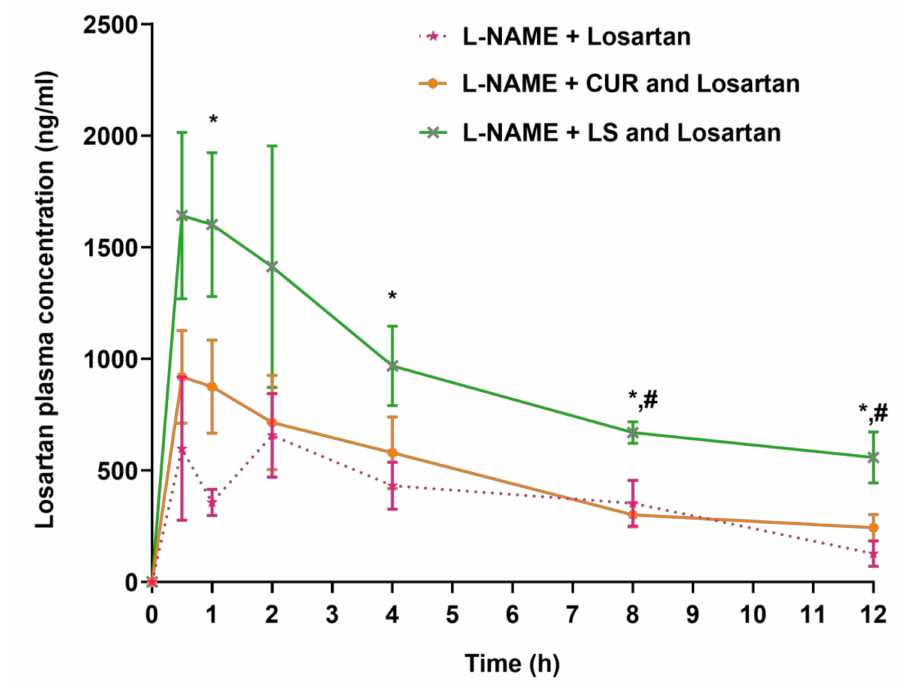
Figure 3. Pharmacokinetic profile of losartan in hypertensive rats treated with CUR and LS ( n = 5, mean ± SEM). CUR, Curcuma longa ; L-NAME, “N-nitro l-arginine methyl ester”; LS, Lepidium sativum